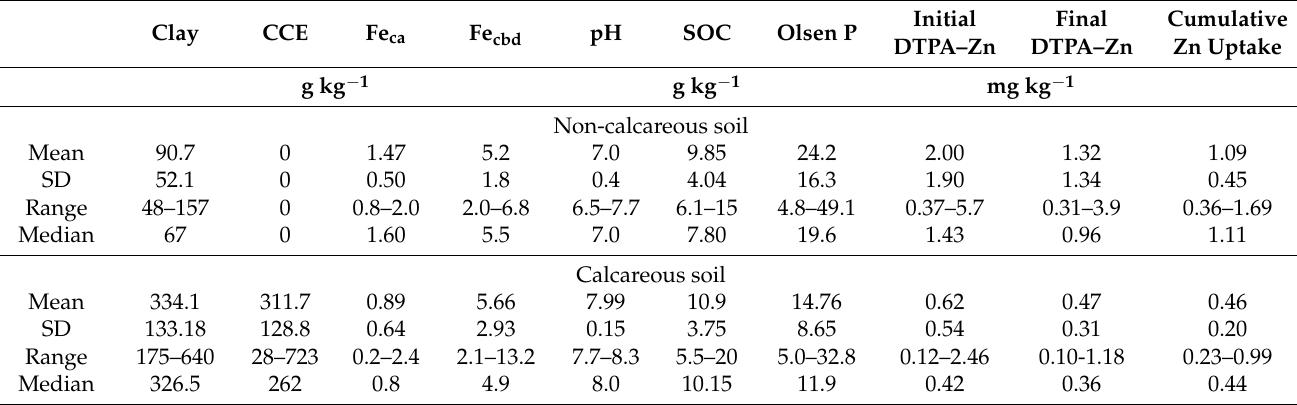
Mean, standard deviation (SD), median and range of the properties of studied soils (n = 36), including, clay content, calcium carbonate equivalent (CCE), soil organic carbon (SOC), initial Olsen P, citrate-ascorbate extractable Fe (Feca), citrate-bicarbonate-dithionite extractable Fe (Fecbd); initial and final diethylenetriamine pentaacetic acid extraction of Zn(DTPA–Zn), before and after 4 cultivations, respectively. Cumulative Zn uptake expressed as mg of Zn per kg of soil.